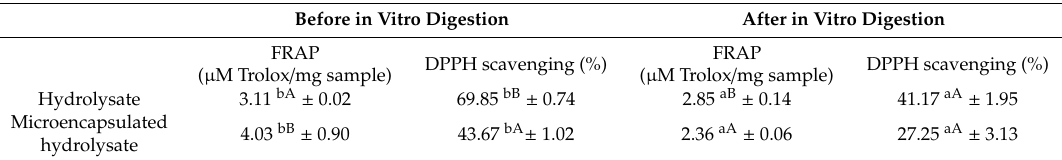
Data are the mean ± SD values. Values marked by di ff erent letters are significantly di ff erent, p ≤ 0.05; a,b: within the same row, separate for the Frap and DPPH assays, A,B: within the same column, separate for the Frap and DPPH